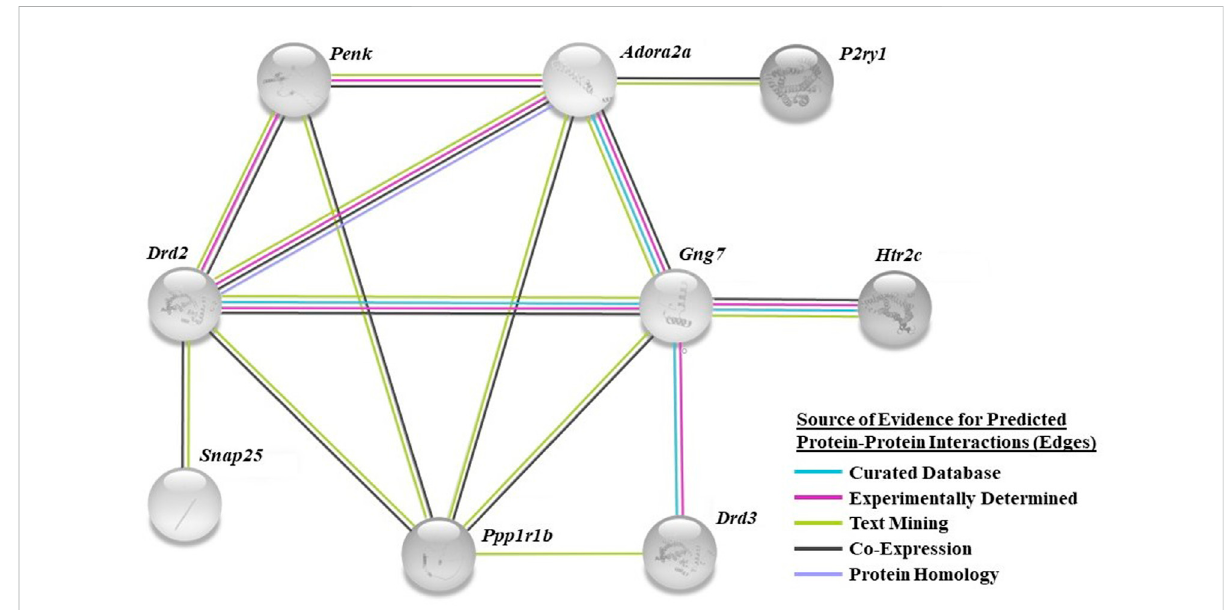
FIGURE 3 STRING bioinformatics analysis identi fi ed a network of predicted interactions in a subset of the selected genes. The speci fi c color of network edges corresponds to the source of evidence for each known or predicted interaction (source: teal, curated database; magenta, experimentally determined; green, text mining; black, co-expression; lavender, protein homology). Con fi dence threshold based upon an interaction score of 0.4 minimum (see